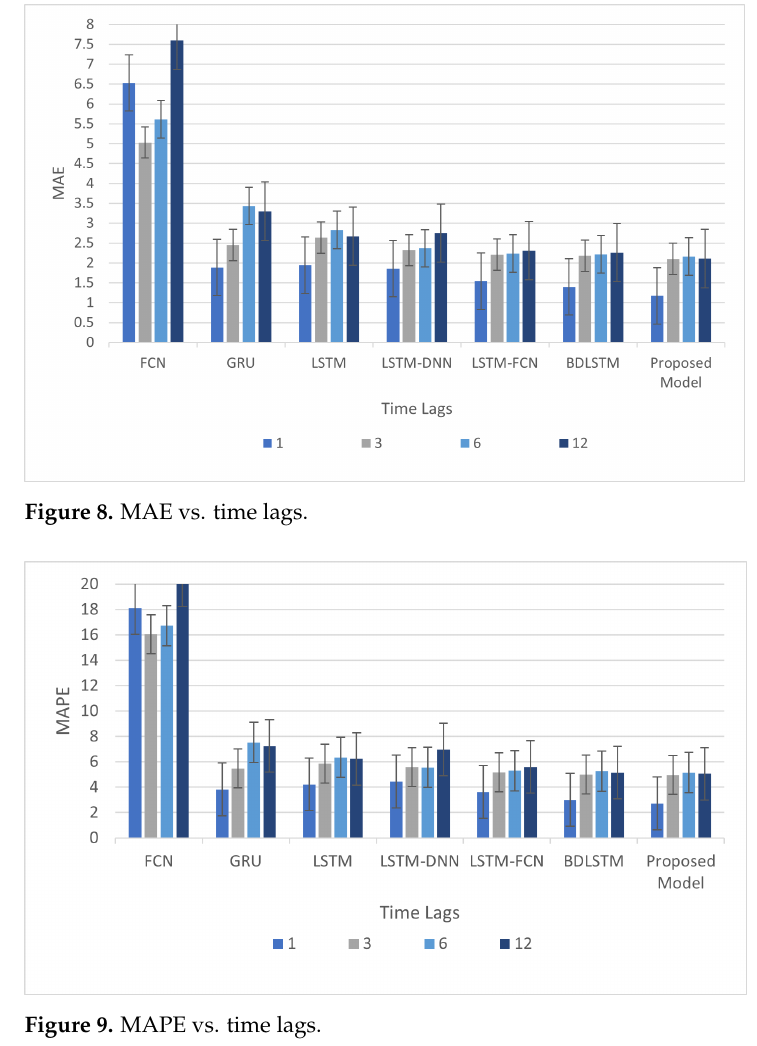
Figure 9. MAPE vs. time